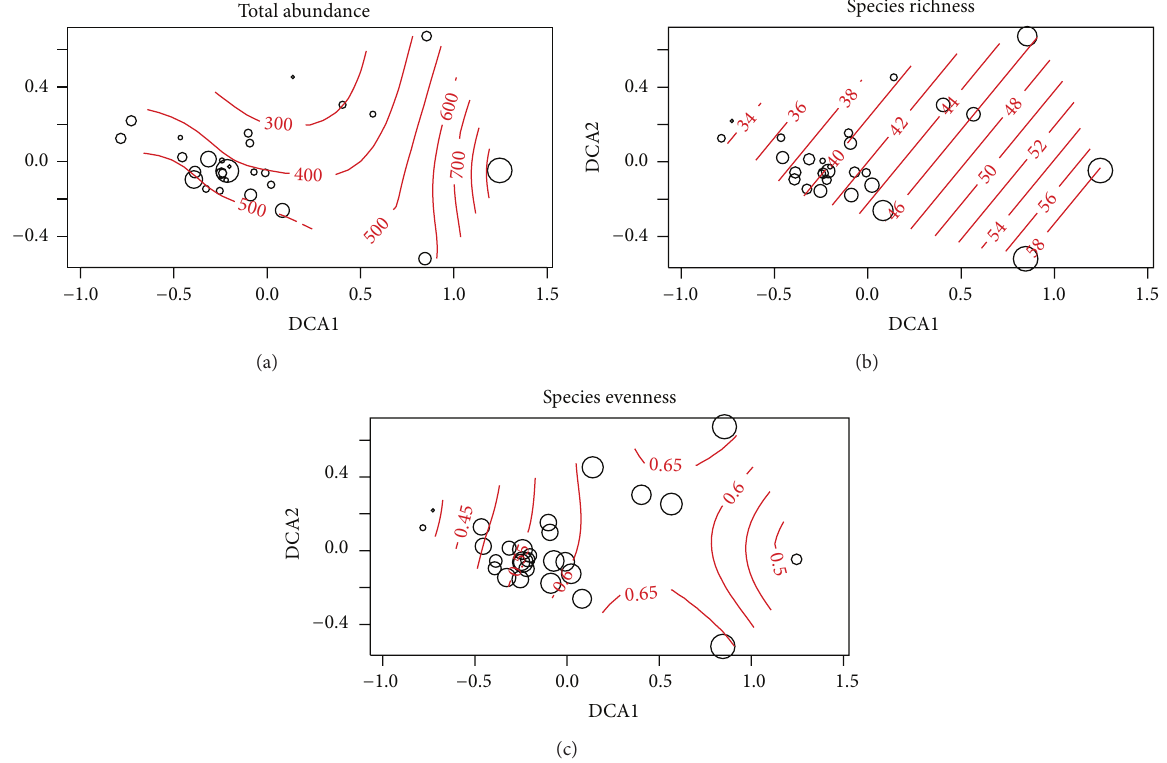
Figure 7: Contour-plots showing patterns of variation in ordination space for (a) total abundance (total number of individuals of all species), (b) species richness, and (c) species evenness for axes 1 and 2 of DCA. 𝑅 32 . The contour-plots are fitted by use of the ordisurf command fitting GAM with Poisson errors. The sizes of the bubbles are proportional to the magnitude of the target value, but not comparable between plots. Axes are scaled in SD units of compositional turnover. The equidistance between contours differs between